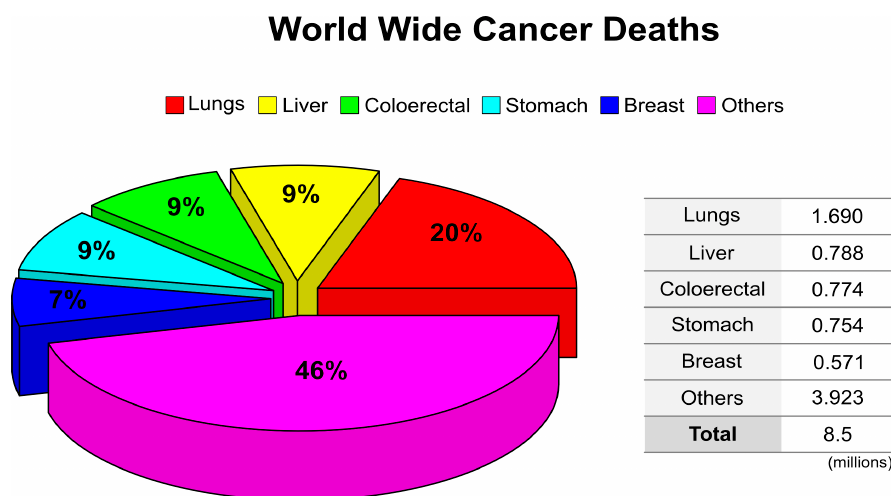
Figure 1. The worldwide percentage distribution of cancer types (https://www.cancer.org/research/cancer-facts-statistics/all-cancer-facts-figures/cancer-facts-figures-2018.html, Accessed on 11 July 2018).